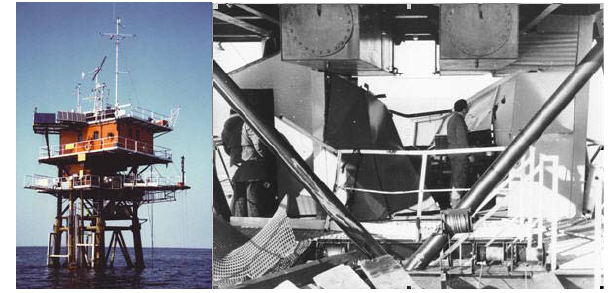
Figure 2 – The oceanographic tower of ISMAR, in the Northern Adriatic Sea, 15 km offshore the Venice coastline. Right panel: the tower (second floor, +7 m above the msl) after the storm of 22 December 1979. The position of the tower is shown in Figure 3.